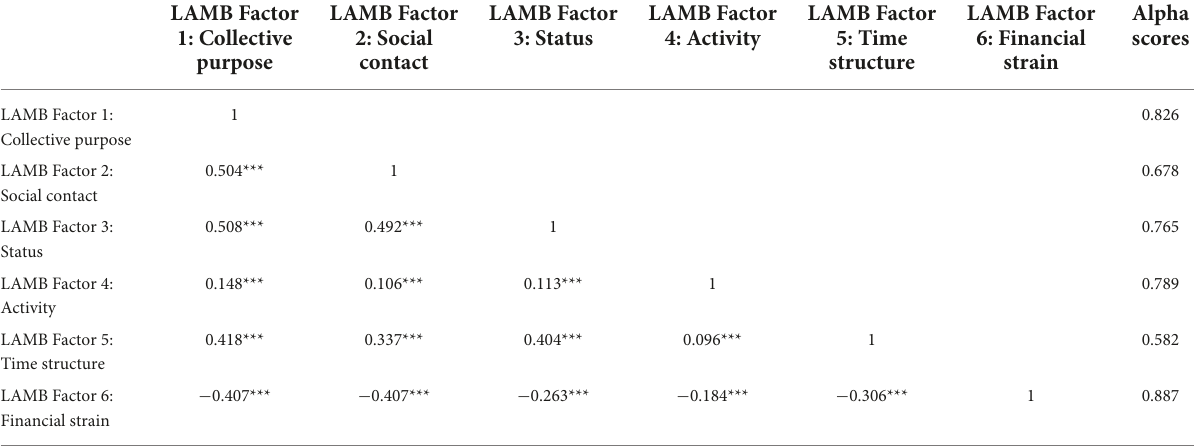
TABLE 1 Correlations between latent and manifest